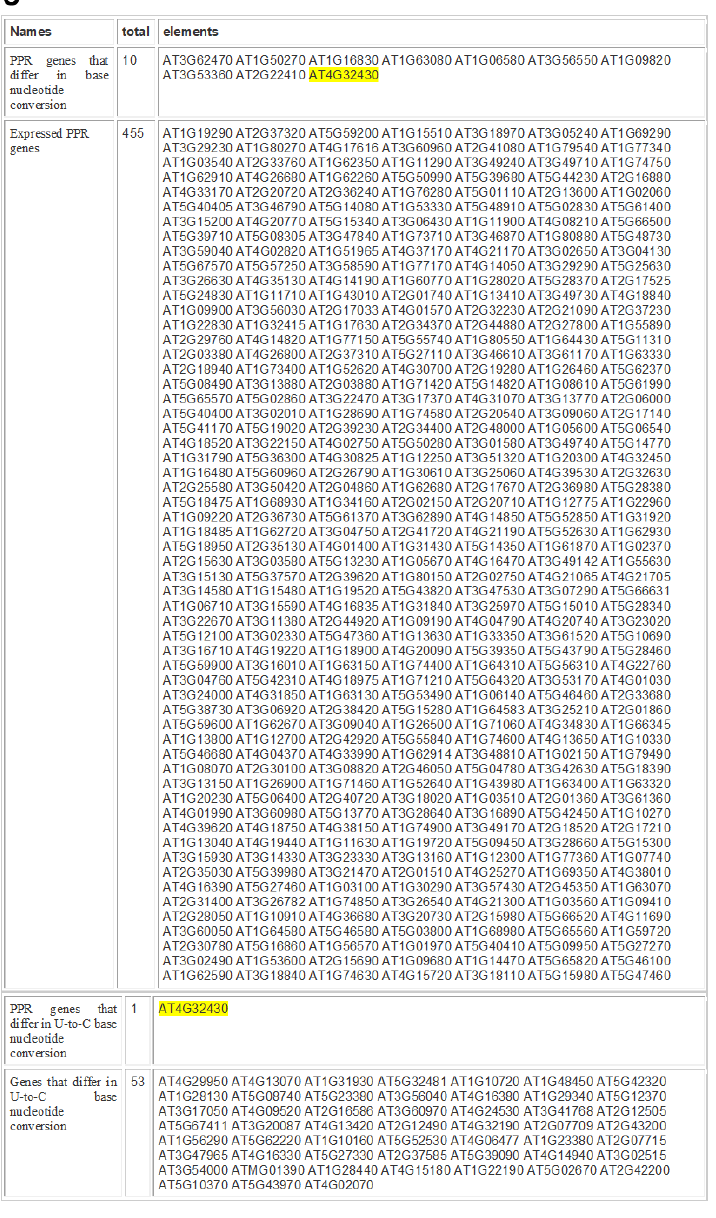
Figure 3. The next-generation sequencing (NGS) data of Arabidopsis for expressed PPR genes. Out of 465 expressed PPR genes, 10 genes including AT3G62470, AT1G50270, AT1G16830, AT1G63080, AT1G06580, AT3G56550, AT1G09820, AT3G53360, AT2G22410, and AT4G32430 showed nucleotide conversion ( A ). Out of 54 U-to-C variant genes, one gene, AT4G32430, was found as PPR gene ( B ). The list of expressed genes, PPR genes that differed in base nucleotide conversions, the genes that differed in U-to-C base conversion, and the PPR gene that differed in U-to-C base conversion are shown in ( C